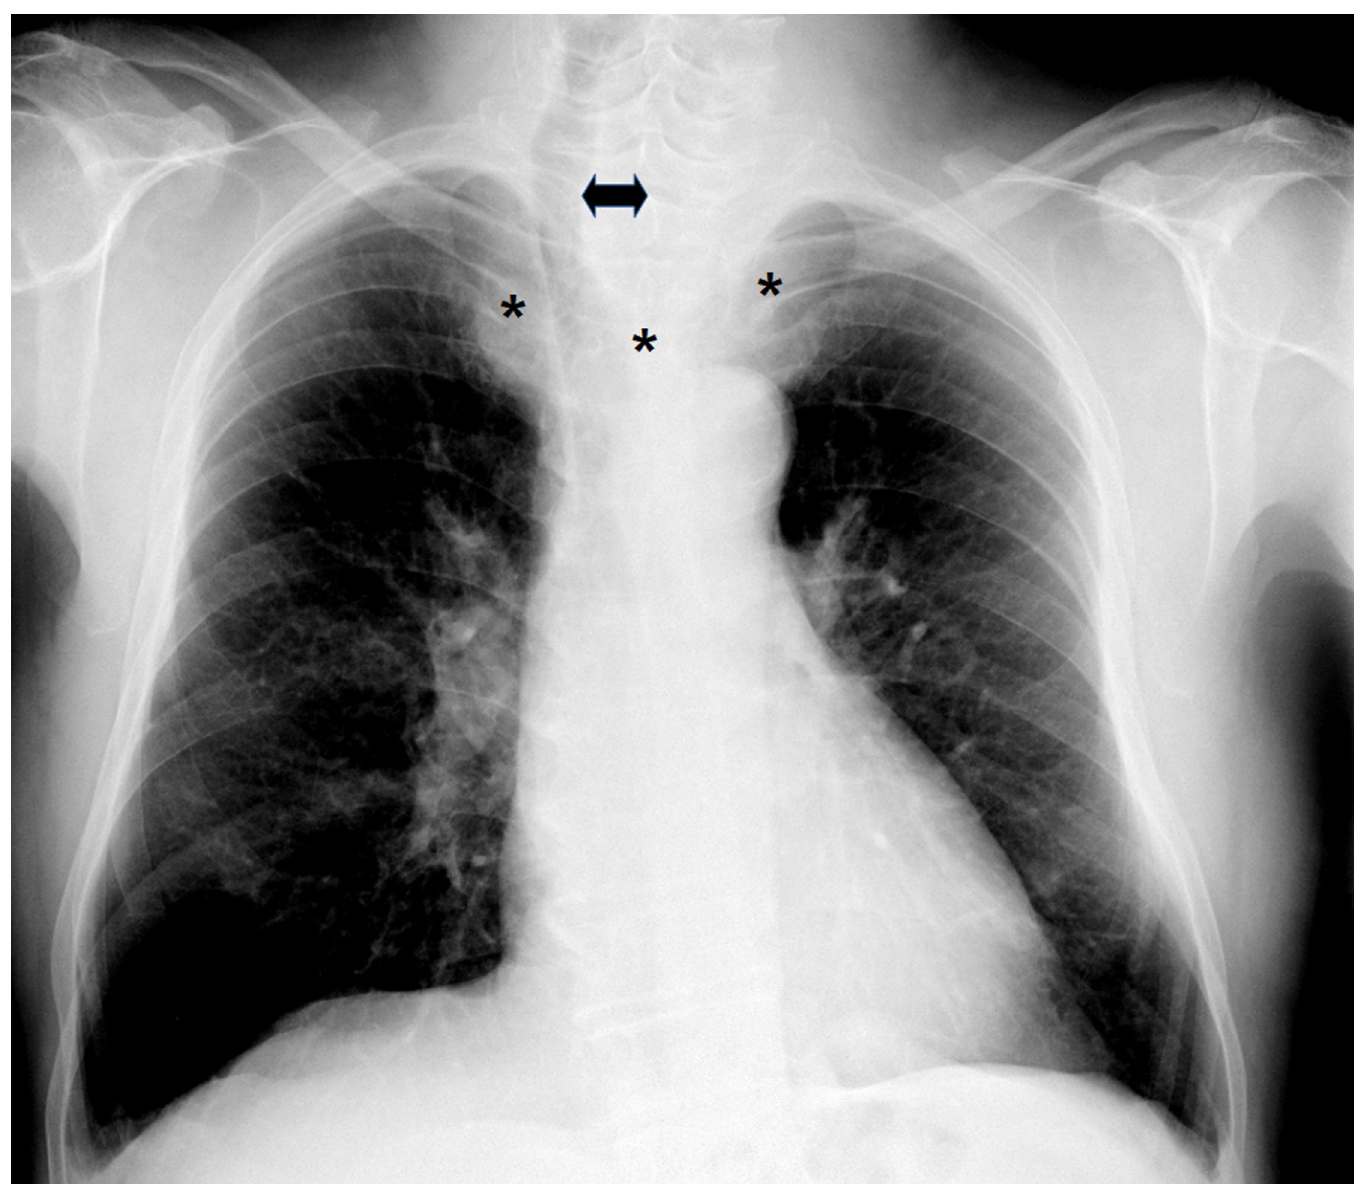
Fig 2. Mediastinal goiter and tracheal deviation at CXR: Asterisks: Mediastinal goiter shadow, arrow: Tracheal deviation.